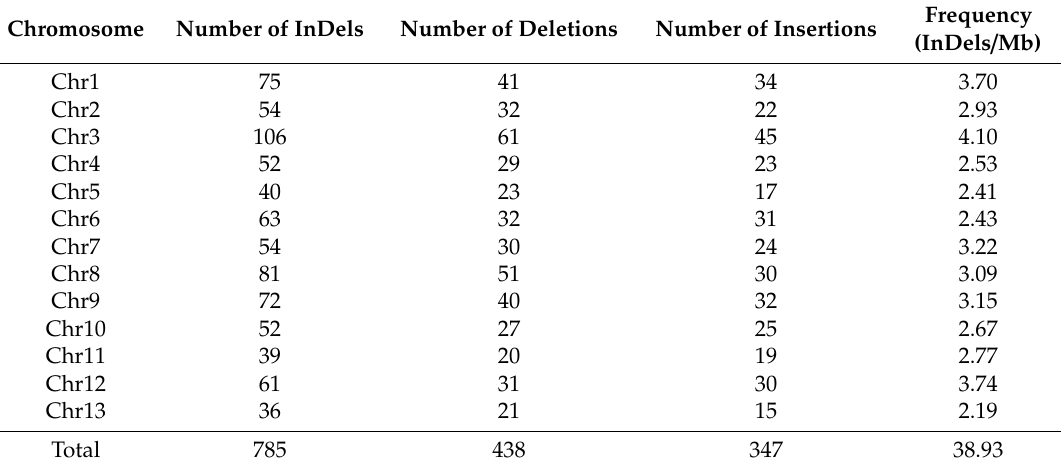
Table 2. Distribution of insertions-deletions (size ≥ 2 bp) in the genome.